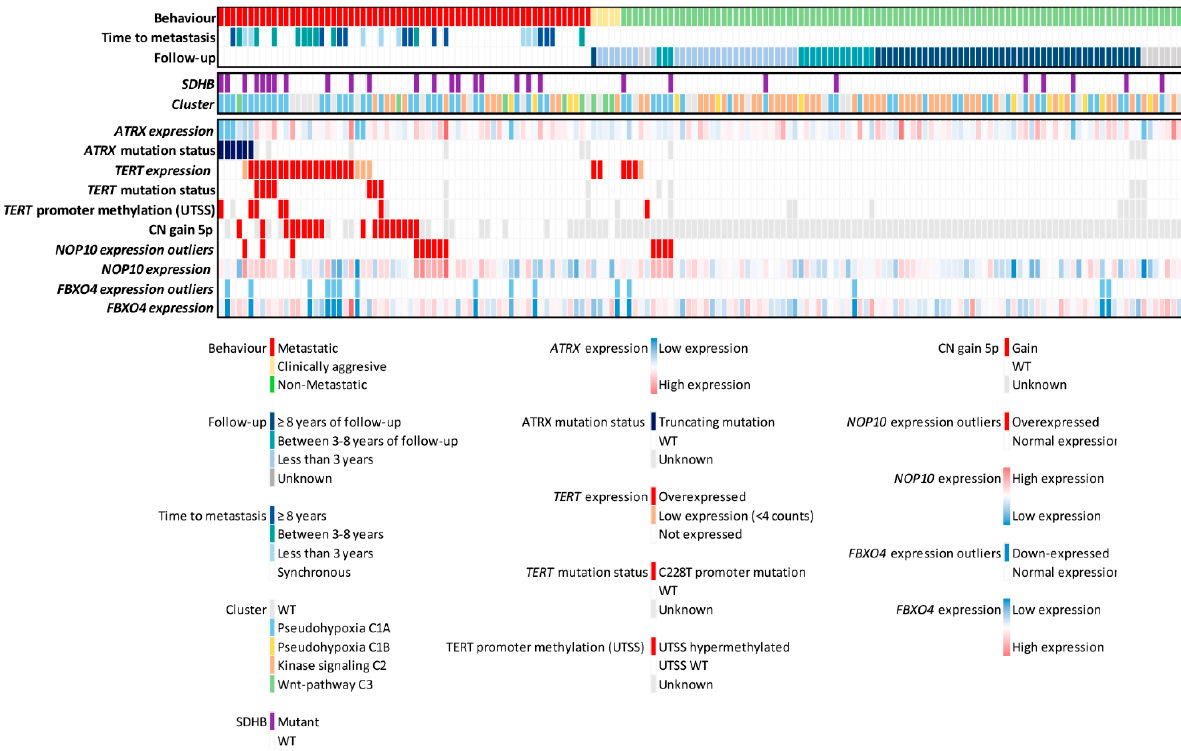
Figure 2. Summary of genomic alterations in PPGL series linked to telomerome events. Tumor behavior and patient follow-up are shown, non-metastatic patients mean follow-up = 7.67 years (min: 9 days, max: 36 years). Patients classification was made according to driver mutations. Events in ATRX include ATRX low expression and ATRX loss of function mutations. TERT events include: TERT overexpression, TERT promoter mutation, TERT promoter hypermethylation (UTSS median value > 16.1%) and CN gain 5p. NOP10 and FBXO4 expression outliers and continuous expression data are shown.